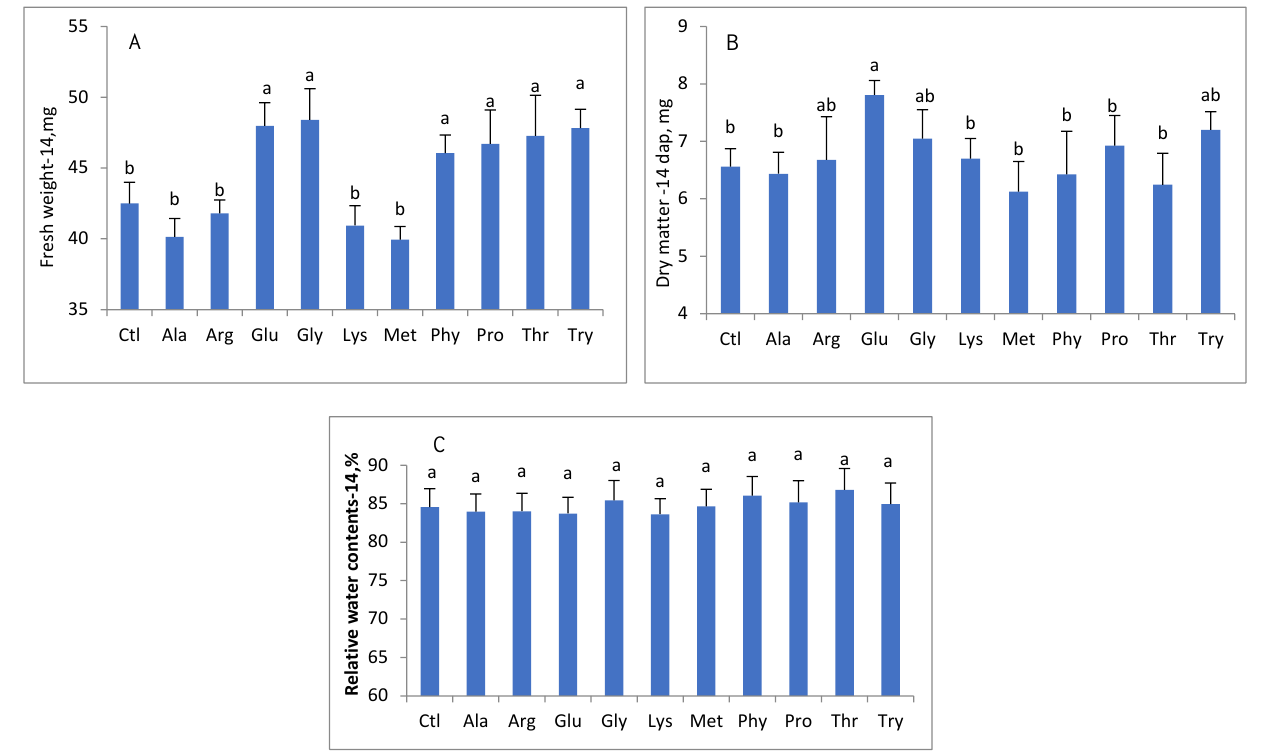
Figure 5. Effect of priming onion seeds with exogenous amino acids. ( A )—Fresh weight-14, mg; ( B )—Dry matter-14, mg; ( C )—Relative water contents-14, %. Ctl (Control); Ala (Alanine); Arg (Arginine); Glu (Glutamine); Gly (Glycine); Lys (Lysine); Met (Methionine); Phy (Phenylalanine); Pro (Proline); Thr (threonine); Try (tryptophan). Columns that share the same letter(s) are not statistically significant at p ≤ 0.01.